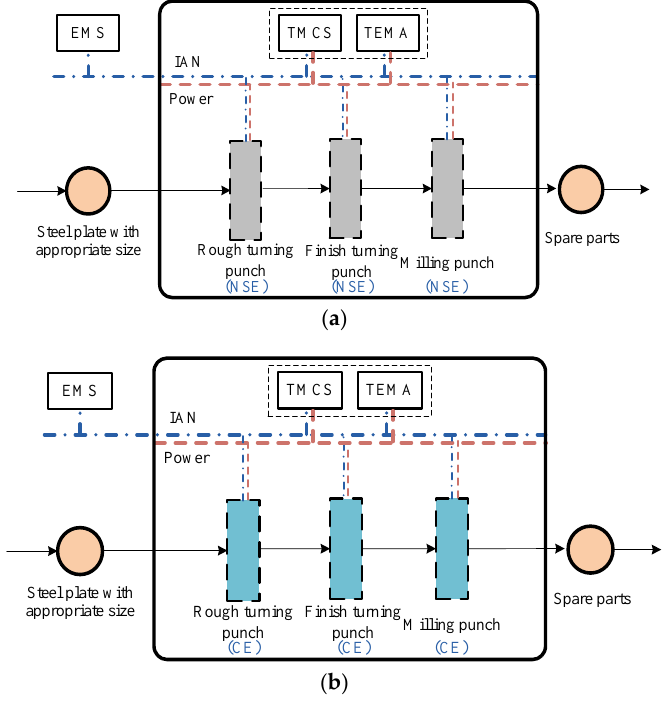
Figure 5. ( a ) The internal structure of PPS#1 and 2; and ( b ) the internal structure of PPS#3, 4 and 5.